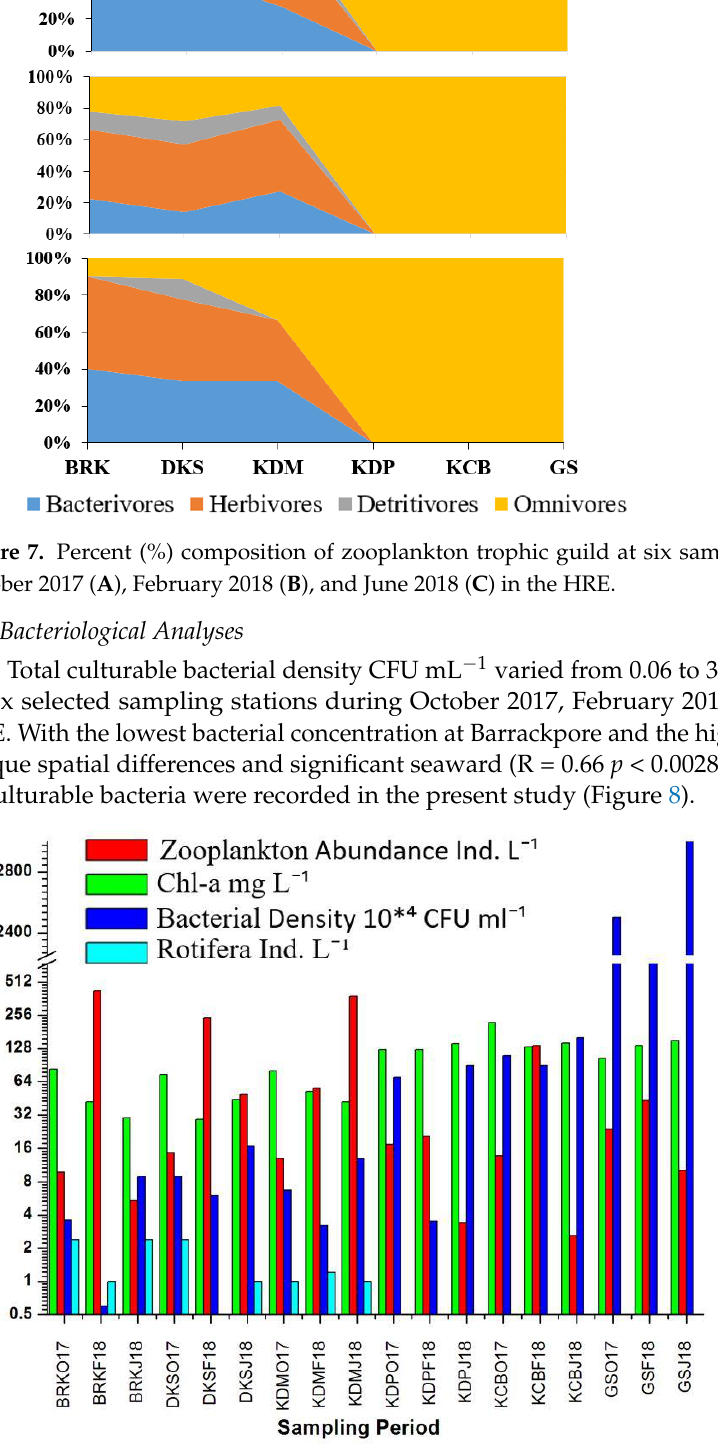
Figure 8. Total Rotifera (Ind L − 1 ), bacterial density (CFU mL − 1 ), total zooplankton abundance, and Chl a recorded in October 2017, February 2018, and June 2018 at six sampling stations in the HRE. Overall bacterial densities were higher at downstream stations (KDP, KCB, and GS) than the upper freshwater stations (BRK, DKS, and KDM). Amongst upstream stations, bacterial densities were negatively correlated with total rotifer density and Chl a concen- tration; however, the correlation was significant for Bacteria vs Rotifera abundance only (Figure 9; Table S6 p < 0.01). The most abundant culturable strains were Bacillus subtilis , Pseudomonas songnensis , and Exiguobacterium aurantiacum , respectively, at BRK, DKS, and GS (Figure 10). Figure 9. Most dominant bacterial strains Bacillus subtilis ( A ), Pseudomonas songnenesis ( B ), and Ex- iguobacterium aurantiacum ( C ) isolated from three selected sampling stations (BRK, DKS, and GS) in the HRE.